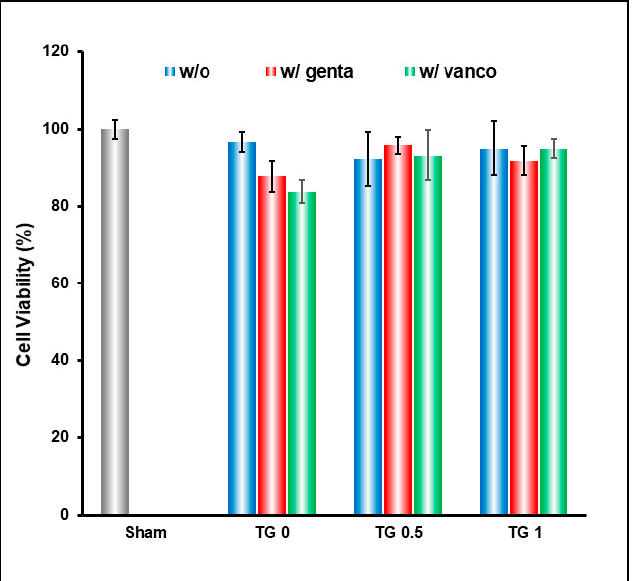
Figure 6. Cell viability result of hydrogel crosslinked with 3 different concentrations of transglu- taminase (TGase), and encapsulating gentamicin and vancomycin. Without crosslink (TG0), the drug released was too rapid and resulted in slight decrease in cell viability; this is remedied by crosslinking the hydrogel to achieve slow release of drugs.